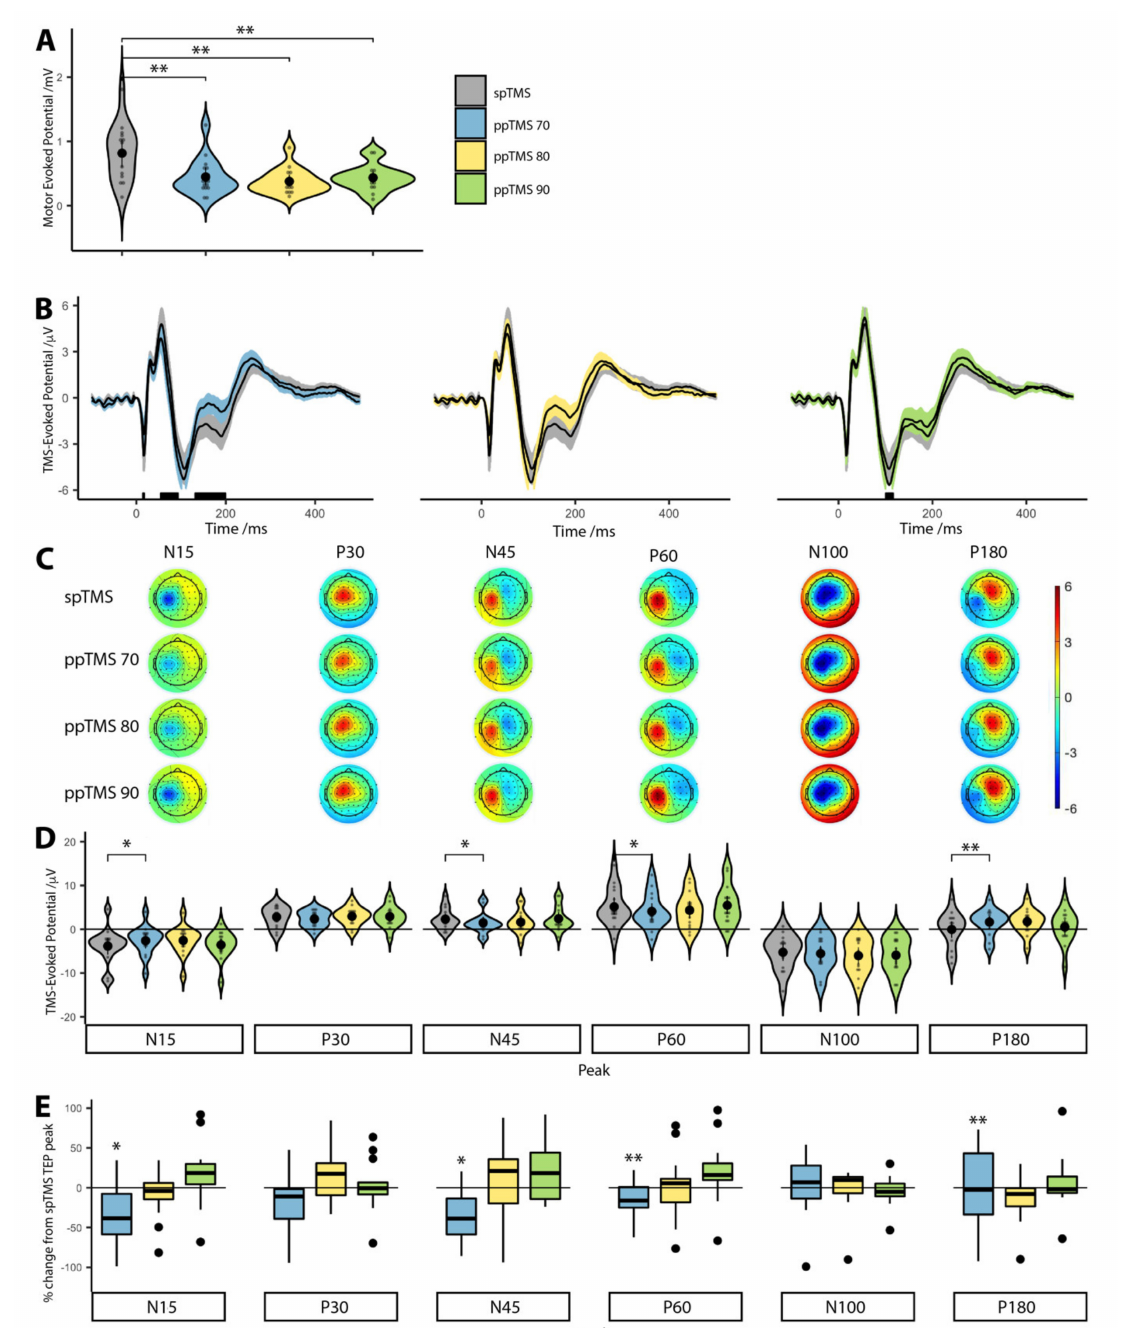
Figure 1. Corticospinal and cortical inhibition measured during ppTMS protocols. ( A ): Corticospinal excitability measured by MEP amplitudes after spTMS and each of the ppTMS conditions. ( B ): Average TEP waveform from four electrodes around the site of stimulation (C1, C3, CP1 and CP3). Shaded areas around the TEP waveform represent standard error of the mean. Black bars under each plot represent statistically significant (p < 0.05) time points, calculated from Wilcoxon signed-rank tests, after FDR correction. ( C ): Scalp plots showing the TEP distribution across our six timepoints of interest, for each condition. ( D ): TEP peaks at six time-points (15 ms, 30 ms, 45 ms, 60 ms, 100 ms and 180 ms) are extracted for each subject and plotted for each stimulation condition. ( E ): Percentage change of individual TEP peaks during ppTMS conditions with respect to spTMS TEPs. Due to differences in polarity between conditions, values were squared first and then represented as a fraction of the spTMS TEP peak. Values below the dashed line depict suppression; those above depict facilitation. Asterisks represent statistically significant differences (* = p < 0.05, ** = p <